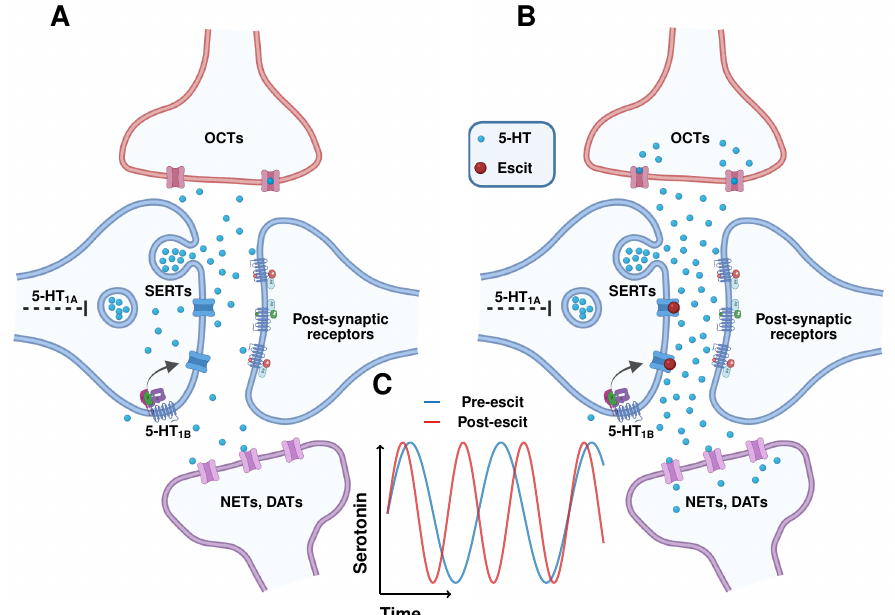
Figure 5. Illustration of control of oscillations. ( A ) Schematic of synaptic elements involved in serotonin release and reuptake in the control state. Serotonin is released from the presynaptic neuron and uptaken, both by local serotonin-specific transporters (SERTs; uptake-1) and other monoamine transporters present in glia and adjacent neurons (NETs, DATs, and OCTs; uptake-2). ( B ) Schematic of synaptic elements involved in release and reuptake in the presence of escitalopram. Here, serotonin is mostly reuptaken via the uptake-2 mechanisms, which have a low affinity for serotonin, but have a high capacity due to the large number of transporters. ( C ) Illustrative representation of extracellular serotonin fluctuations and their increase in frequency in the presence of escitalopram due to the activation of the high-capacity uptake-2 system. Created with Biorender.com (accessed on 6 May